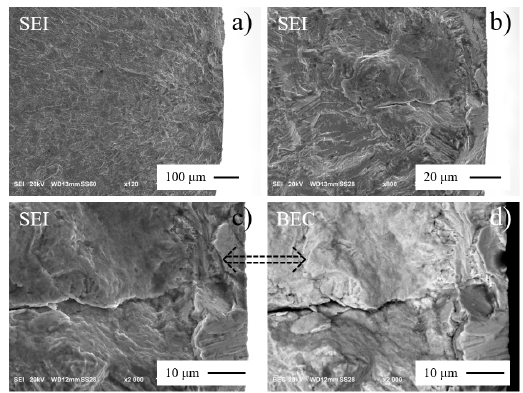
Figure 11. SEM micrographs of fracture surface of aged Inconel 718 ( σ a = 540 MPa, N f = 1.57 ∗ 10